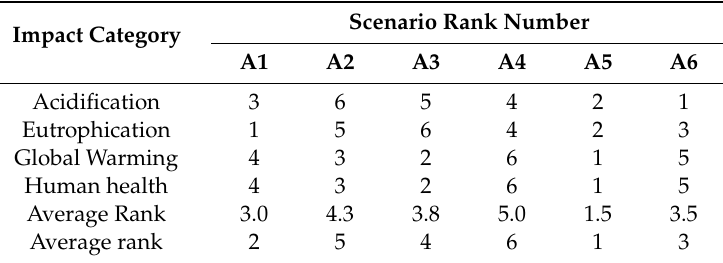
Table 6. Ranking of MSW management